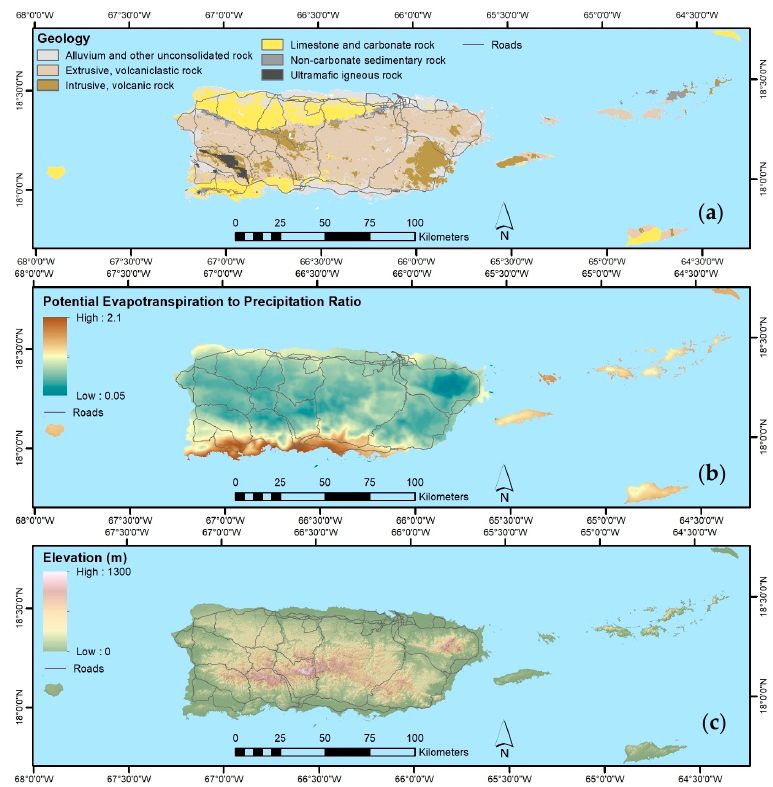
Figure 1. Puerto Rico and the Virgin Islands: ( a ) geological substrate; ( b ) potential evapotranspiration to precipitation ratio, a climatic indicator of moisture; and ( c ) elevation. The highest elevation areas are cloud forest areas.